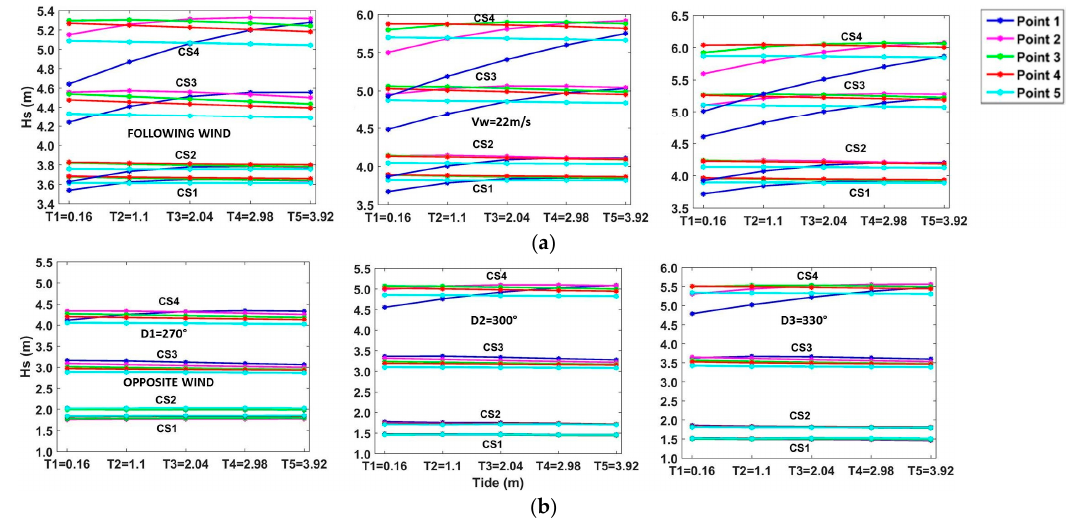
Figure 11. High wind conditions ( V w = 22 m/s): H s variations along the reference points corresponding to the three different directions of the incoming waves (D1, D2, D3) and to the five tide conditions (T1, T2, T3, T4, and T5) for all the case studies considered (CS1, CS2, CS3, CS4): ( a ) following wind; and ( b ) opposite wind.